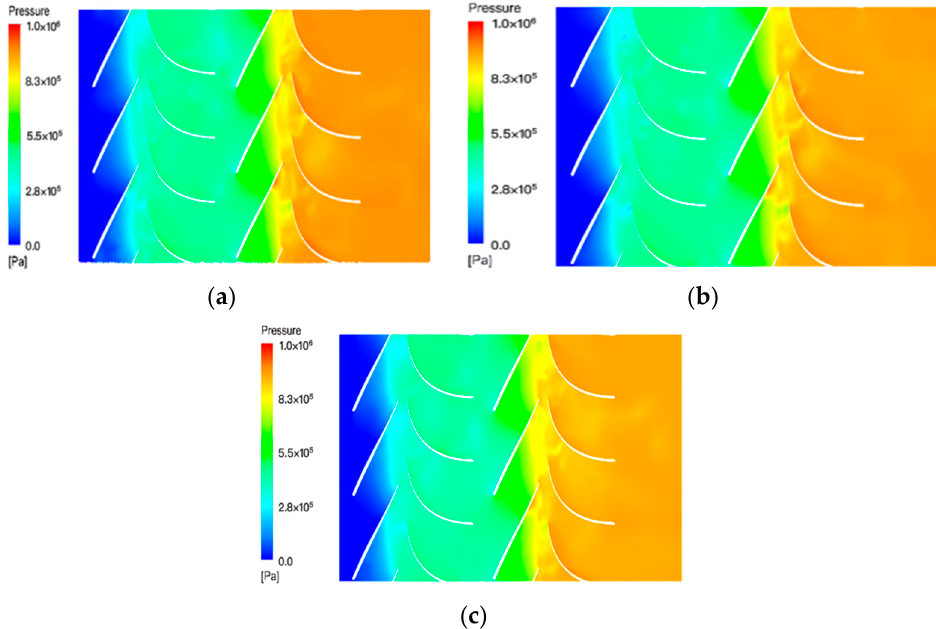
Figure 11. Pressure distribution on first-stage impeller-guide vane B2B view. ( a ) 1400 kg/m 3 ; ( b ) 1900 kg/m 3 ; ( c ) 2800 kg/m 3 .